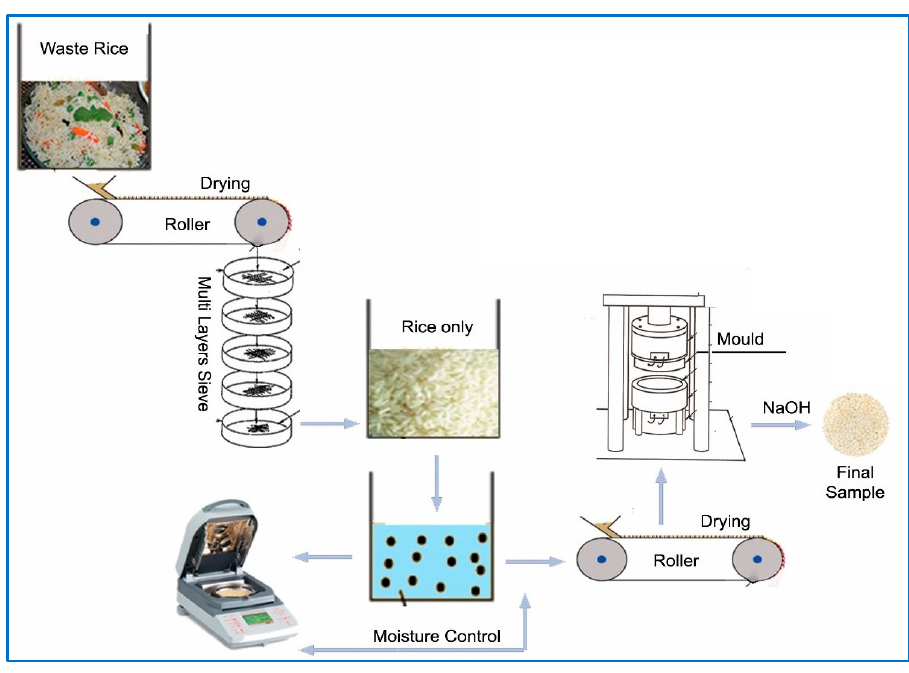
Figure 1. Rice cake puffing process.